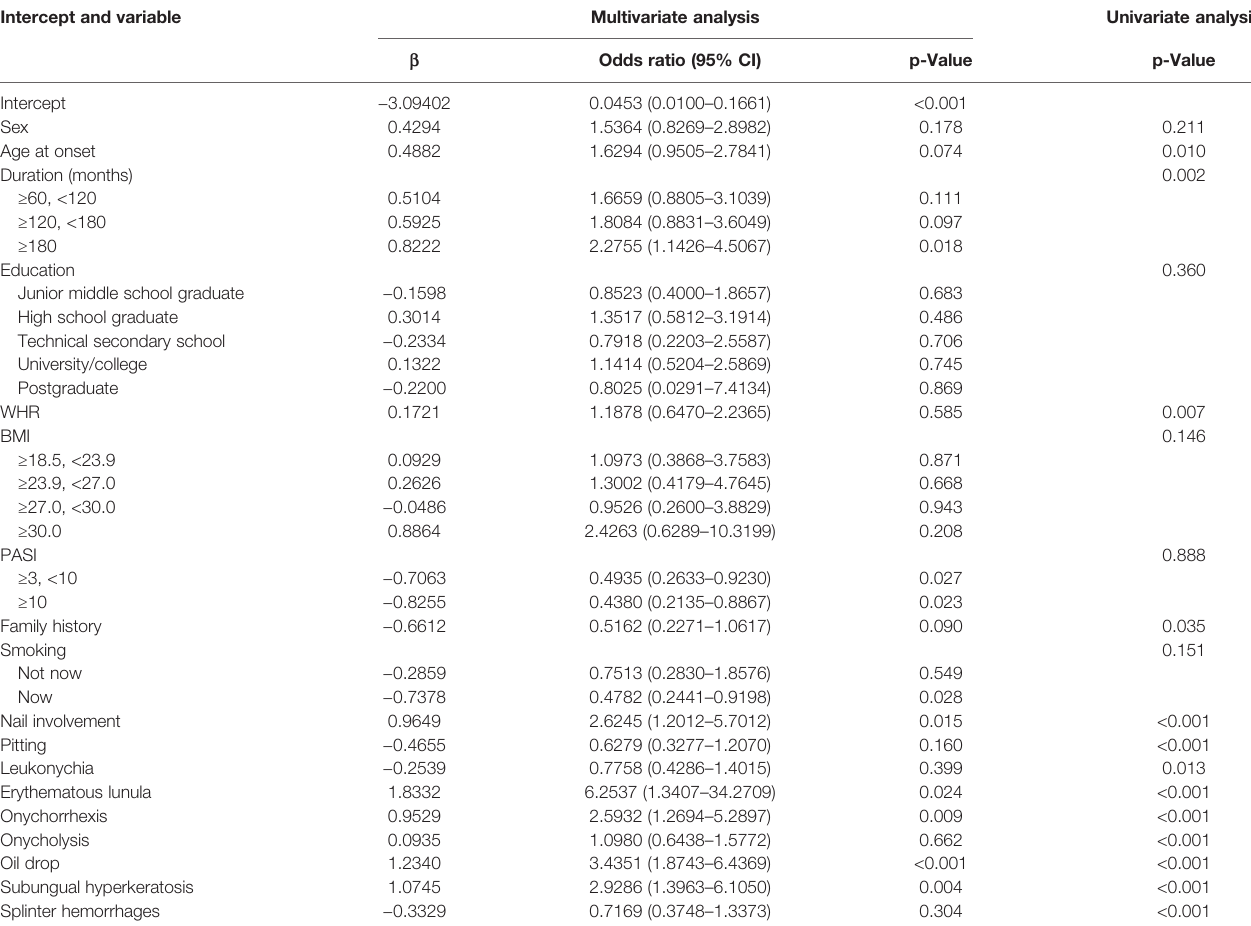
TABLE 2 | The multivariate and univariate logistic regression analysis of psoriatic